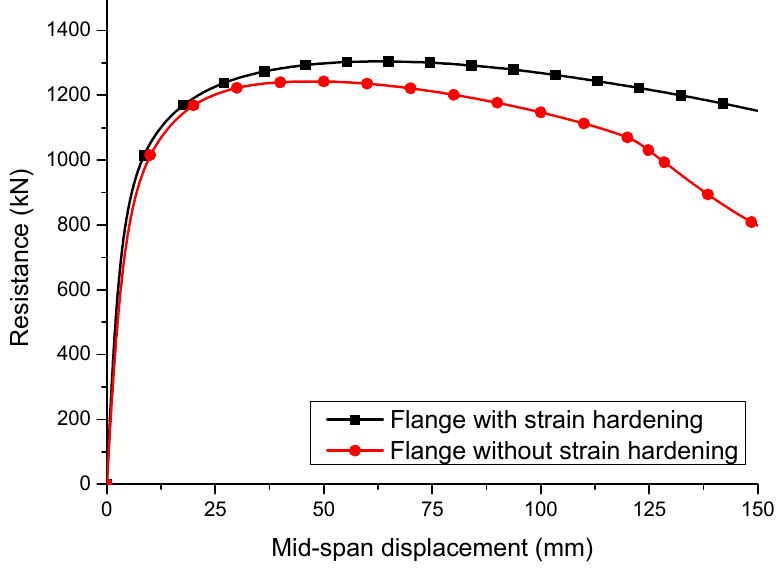
Figure 12. Effect of strain hardening on the resistance.